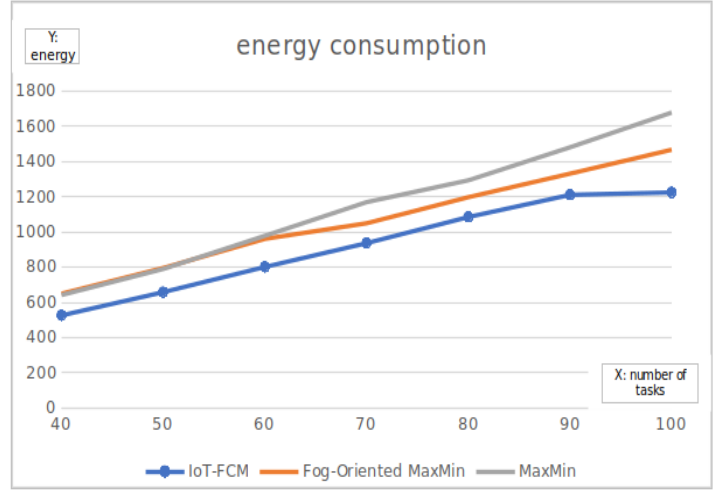
Figure 10. The sum of the energy consumption of all fog